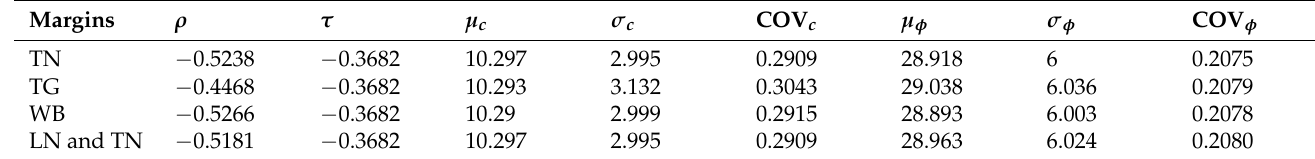
Figure 14. Scatter plots of soil parameters associated with different CCRFs. ( a ) TN margins. ( b ) TG margins. ( c ) WB margins. ( d ) LN and TN margins. Table 5. Statistics of CCRF variables associated with candidate